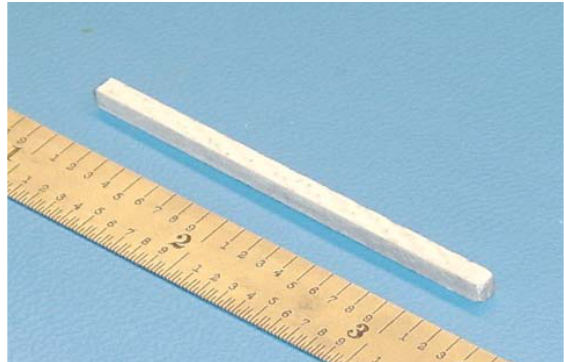
Figure 3. Finished bend beam specimen, nominally 56.5 mm L × 2.8 mm W × 2.8 mm